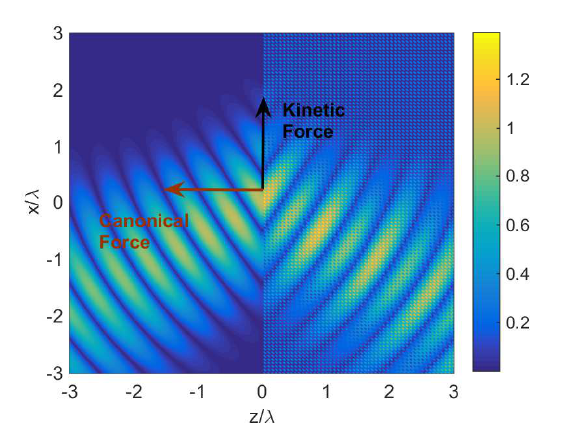
Figure 2: Demonstration of a refracted Gaussian beam at a matched negative refractive index boundary. The incident medium z < 0 is vacuum ( µ 0 , (cid:15) 0 ) and the transmitted is a matched left-handed medium ( − (cid:15) 0 , − µ 0 ) . The parameters for incident TM field are amplitude H 0 = 1 A/m , inci- dent wavelength λ 0 = 1064 nm , beam waist w = λ 0 , and NA = 0 . 8